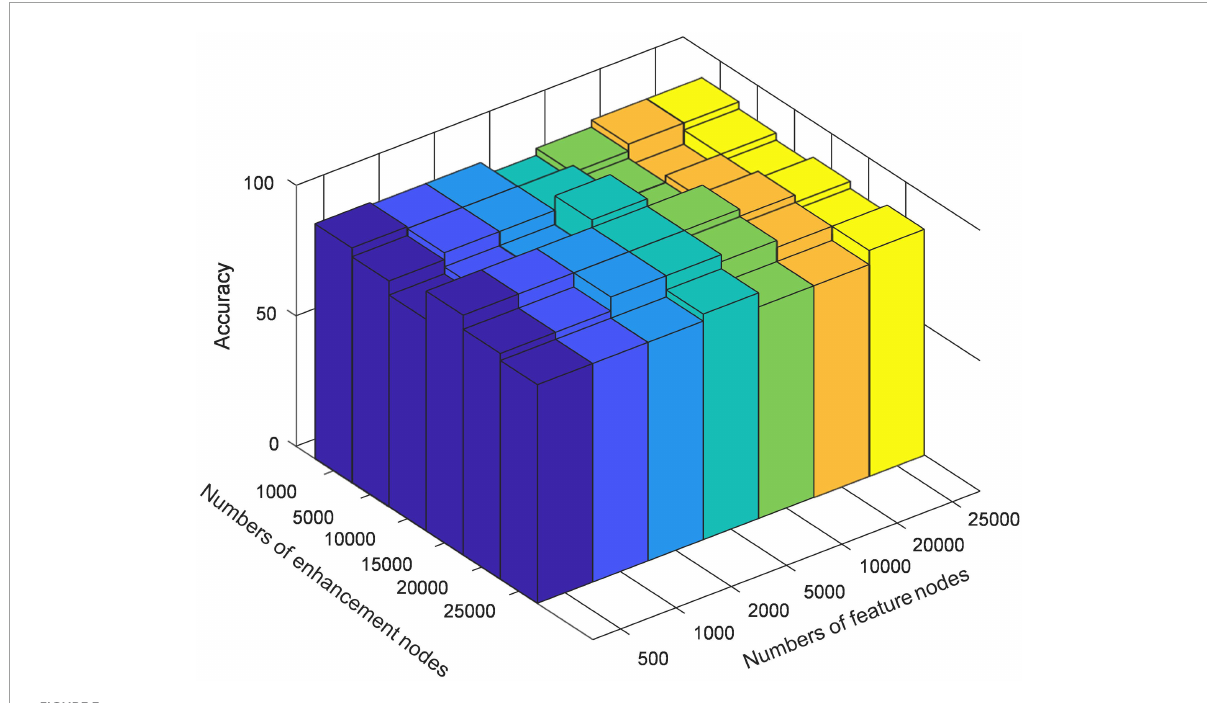
FIGURE3 The classification accuracy on different mapping features